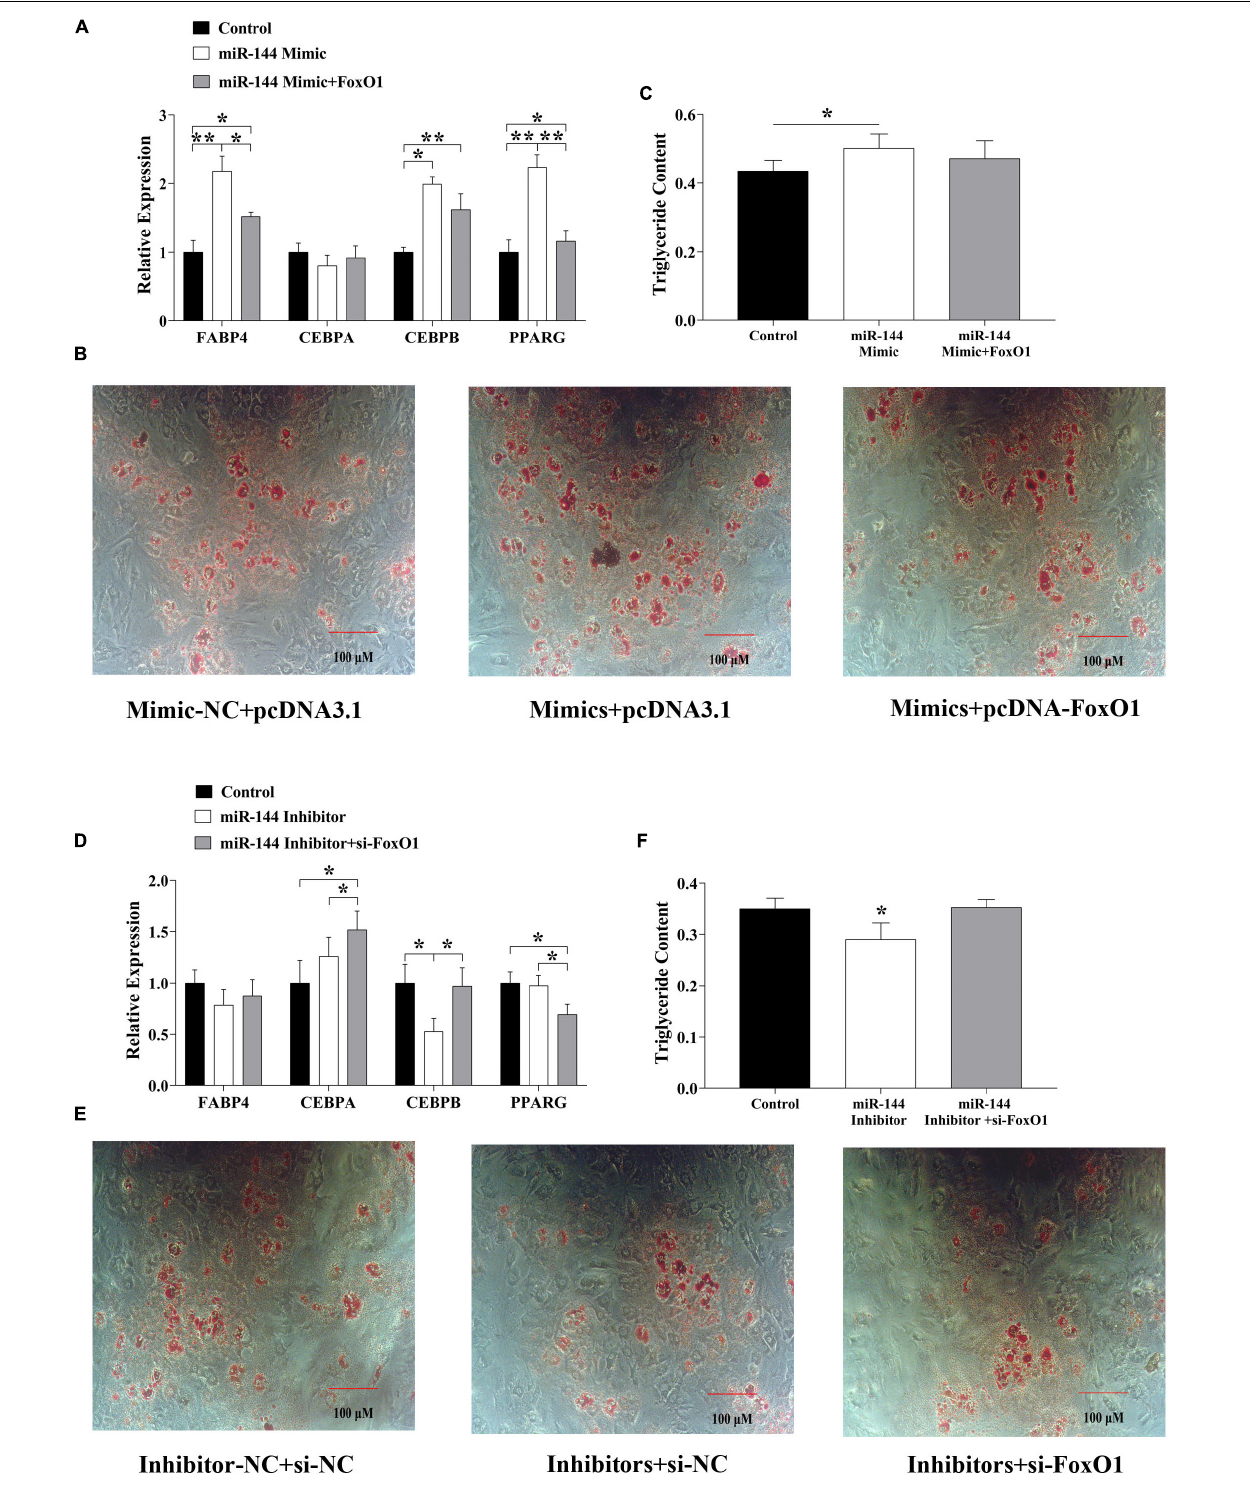
FIGURE 4 | MiR-144 and FoxO1 co-regulated the adipogenesis. (A) Detected adipogenic label genes expressed in the miR-144 mimics and FoxO1 co-transfected group. (B,C) After 8-day differentiation inducer medium (DIM) stimulation, oil red O staining (B) , and triglyceride assay (C) . (D) Detected adipogenic label genes expressed in the miR-144 inhibitors and si-FoxO1 co-transfected group. (E,F) After 8-day differentiation inducer medium (DIM) stimulation, oil red O staining (E) , and triglyceride assay (F) . * p < 0.05, ** p < 0.01.